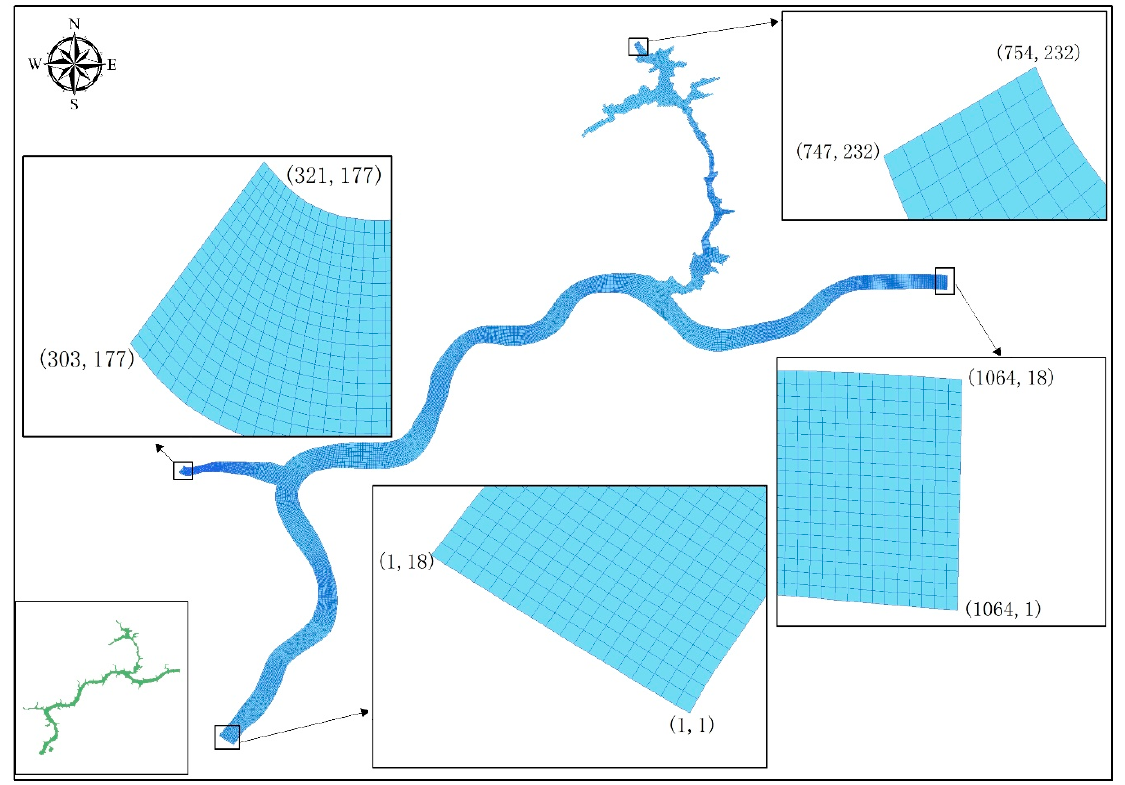
Figure 6. The structure of original two-dimensional grids made by the software Delft3D.